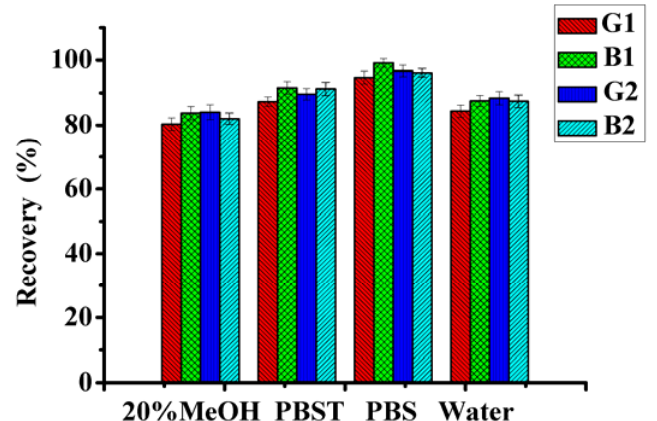
Figure 3. Effect of different washing solvents on the efficiency of IAC (aflatoxins spiked in peanut, 5 μ g·kg − 1